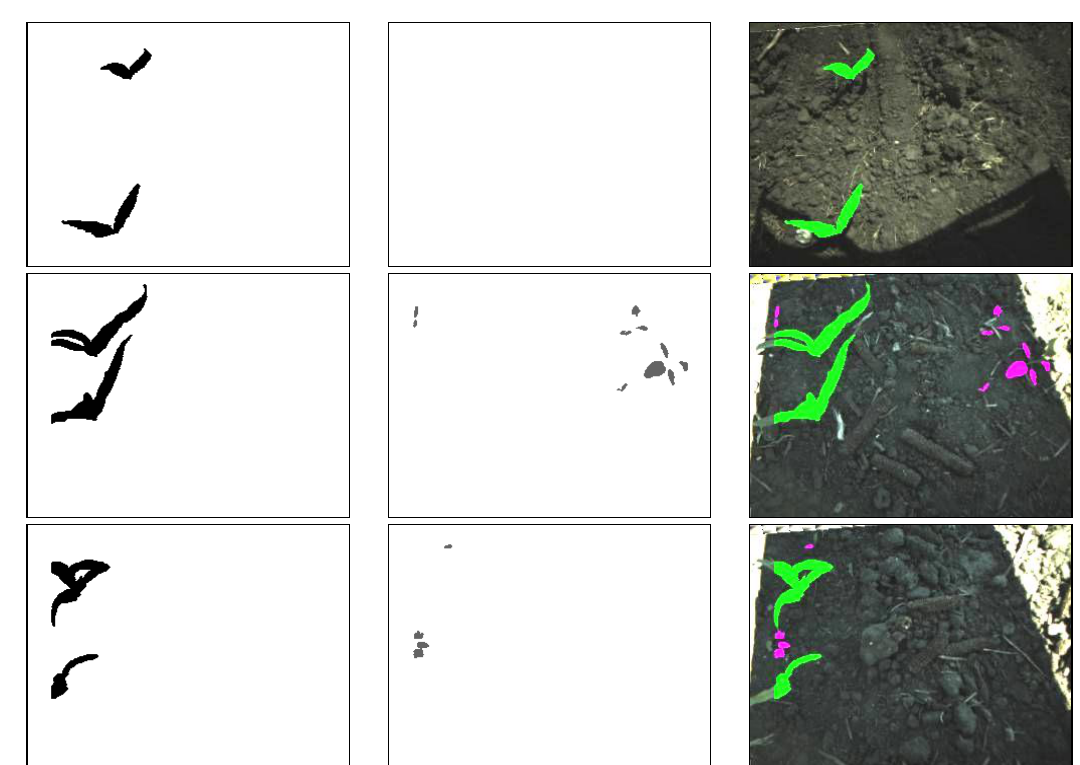
Figure 6. Example result images of weed identification: image with corn plants ( left column ), image with weeds ( middle row ) and field image with identified weeds (purple) and corns (green) ( right column